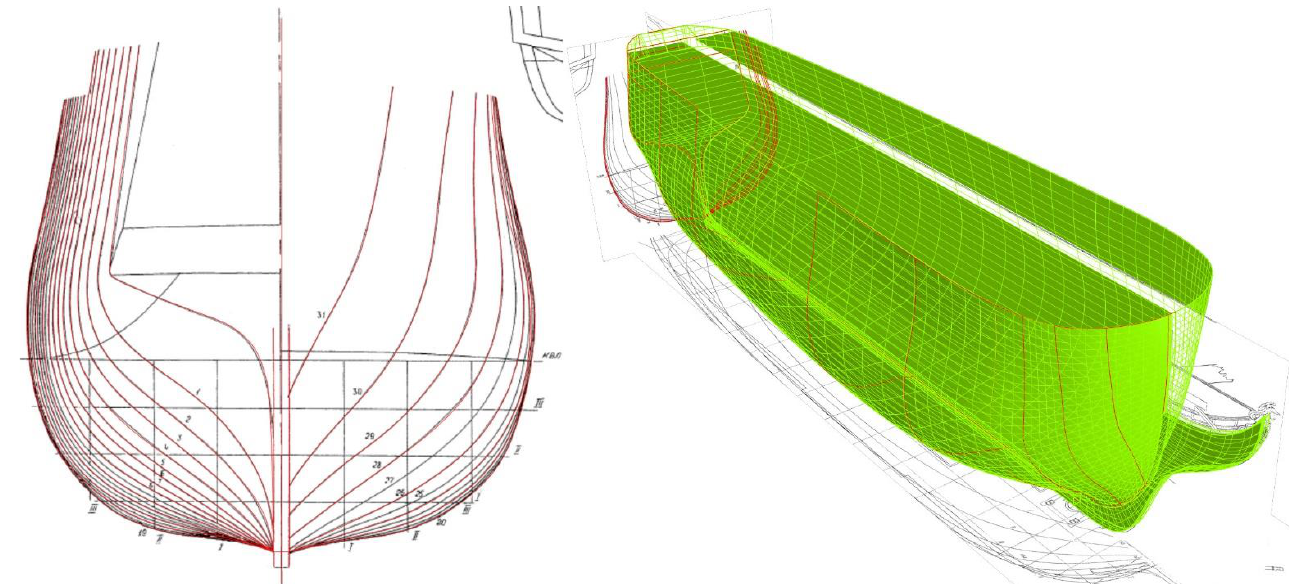
Figure 2 . Drawings of the Azov Ship: left — lines plan; right — surfaces constructed in Rhino3D.